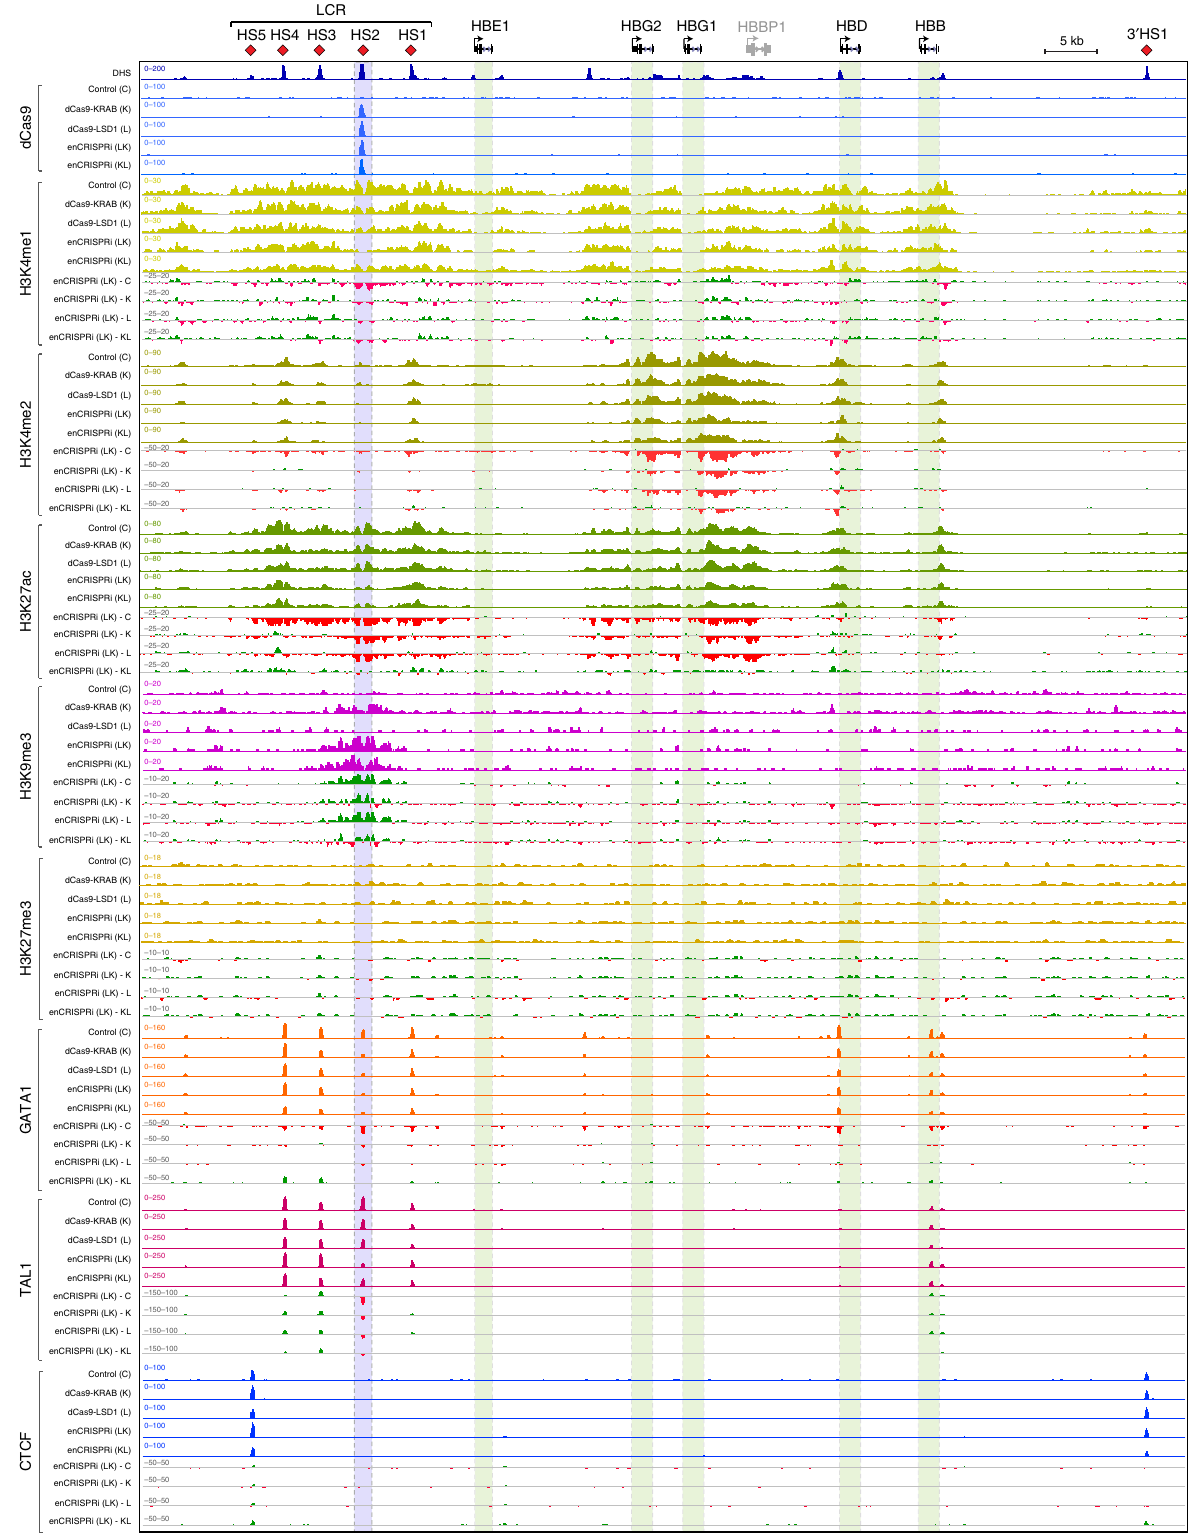
Fig. 3 Locus-speci fi c epigenetic reprogramming at the β -globin gene cluster. Density maps are shown for ChIP-seq of dCas9, active histone marks (H3K4me1, H3K4me2, and H3K27ac), repressive H3K9me3 and H3K27me3, GATA1, TAL1, and CTCF at the β -globin cluster (chr11: 5,222,500 − 5,323,700; hg19) in K562 cells coexpressing nontargeting sgGal4 (control or C) or sgHS2 with dCas9-KRAB (K), dCas9-LSD1 (L) or enCRISPRi (LK and KL). Regions showing increased or decreased ChIP-seq signals in enCRISPRi (LK) relative to control, dCas9-KRAB, dCas9-LSD1 or enCRISPRi (KL) (enCRISPRi — C, enCRISPRi — K, enCRISPRi — L, or enCRISPRi — KL) are depicted in green and red, respectively. Blue bars denote the sgRNA-targeted HS2 enhancer. Green bars denote the β -globin genes. Independent replicate experiments are shown as rep1 and rep2 in Supplementary Figs. 2 and 3,